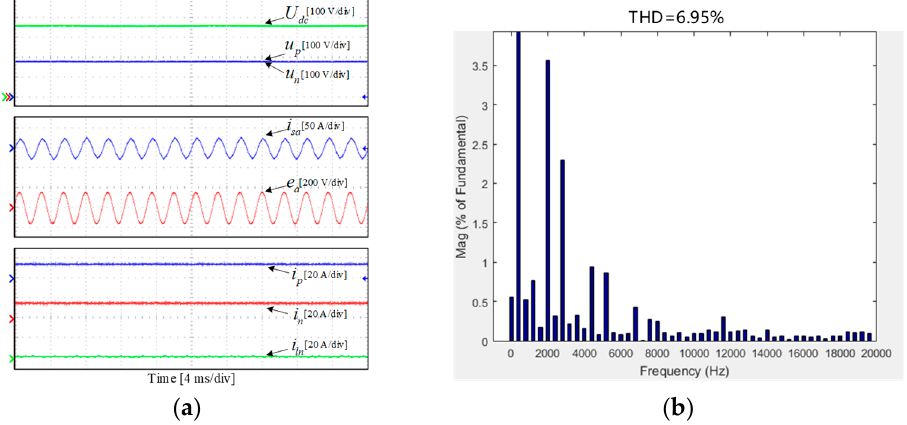
Figure 14. Experimental results based on the optimized 18-sector division. ( a ) Voltage and current